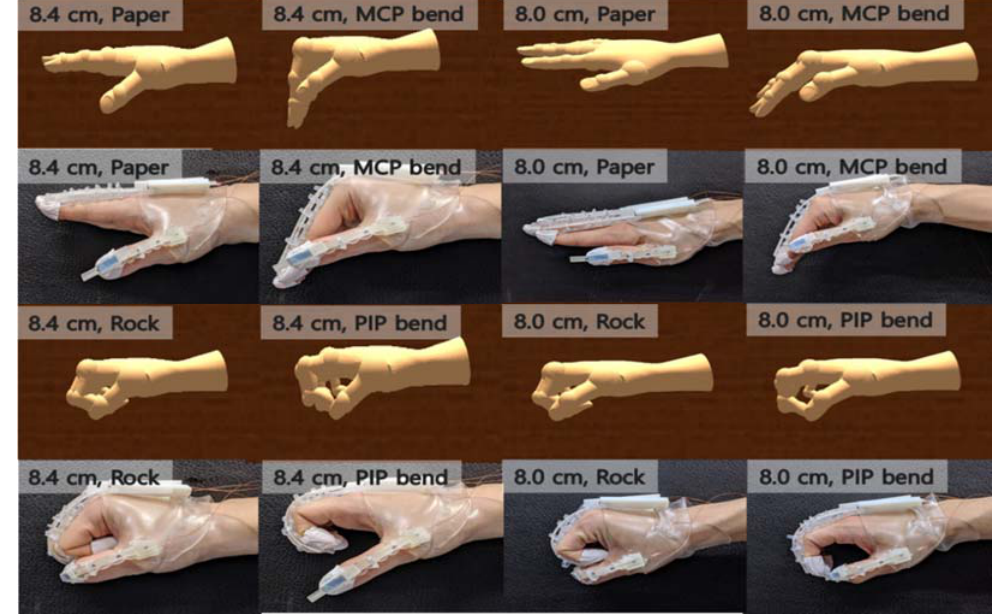
Figure 12. Comparison between real and rendered finger angle images.